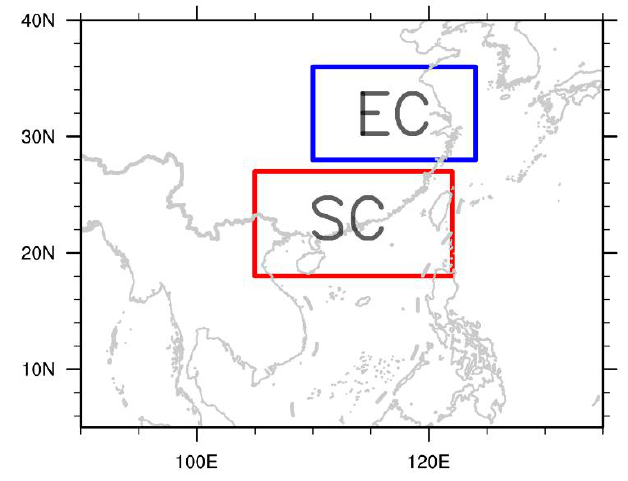
Figure 10. Selected regions. Red box (18–27° N, 105–122° E) indicates SC, South China; blue box indicates EC (28–36° N, 110–124° E), East China.